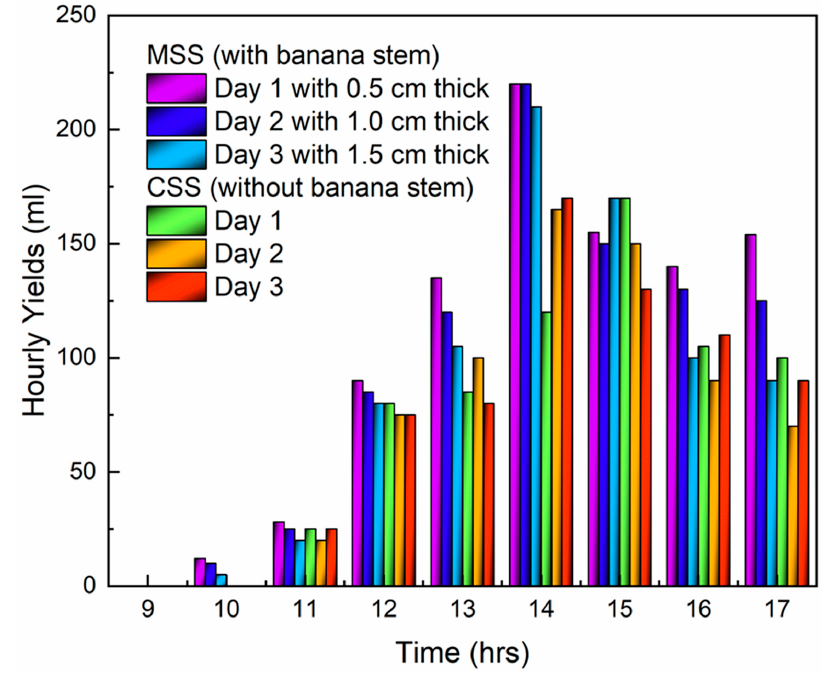
Figure 5. Variation in the hourly yield.